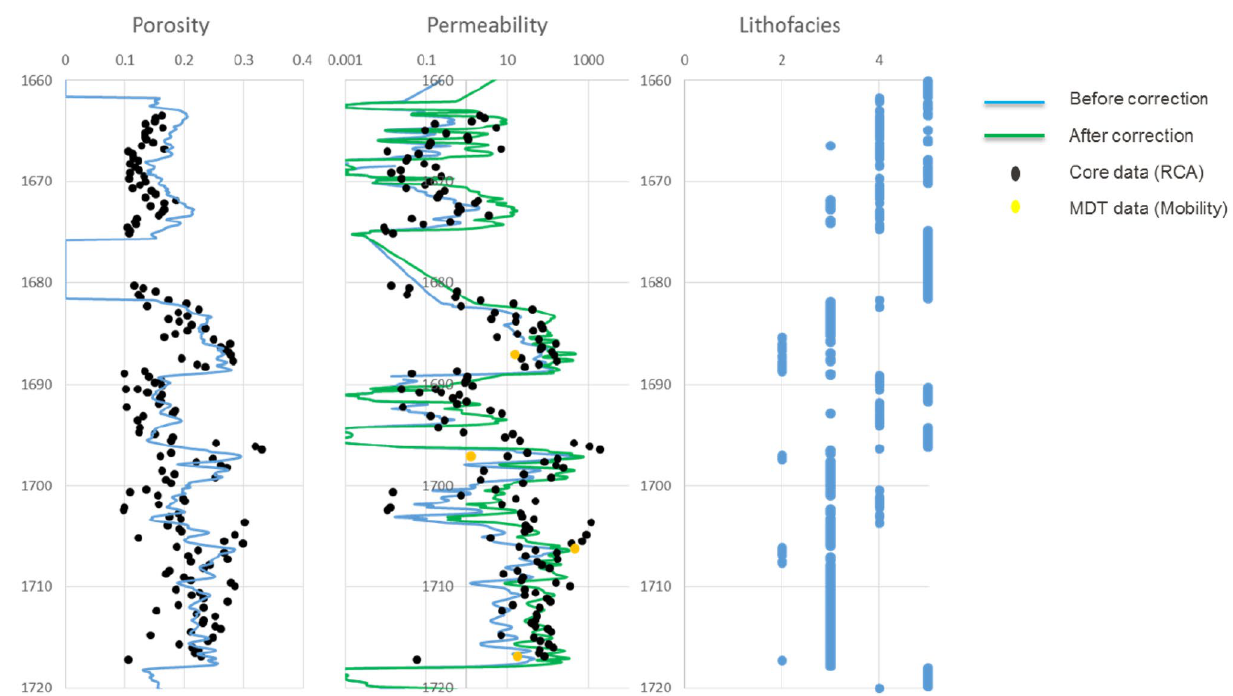
Fig. 9 Illustration of permeability multipliers derived per electro-facies to match the routine core analysis (RCA)/MDT data